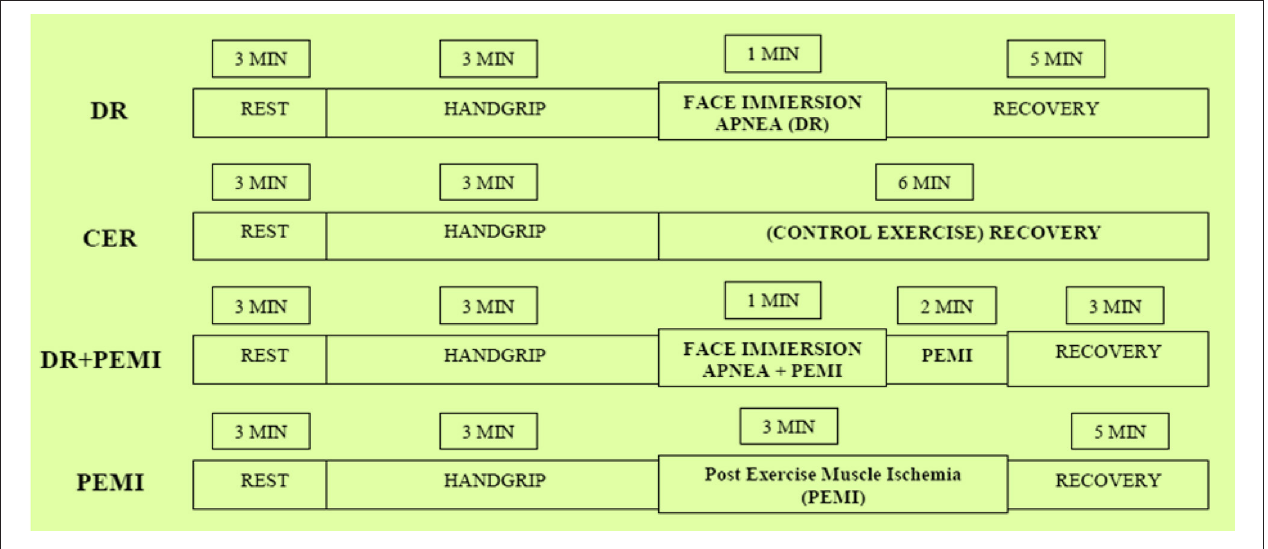
FIGURE 1 | Schematic representation of the four phases of the experimental design. See text for details.